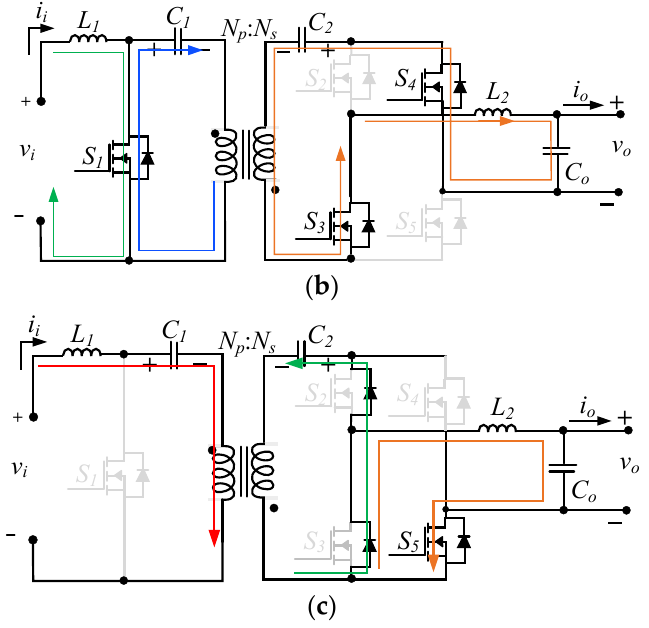
Figure 8. MCI as a DC/AC inverter when i o is positive: ( a ) St inv 1 , ( b ) St inv 2 , and ( c ) St inv 3 .